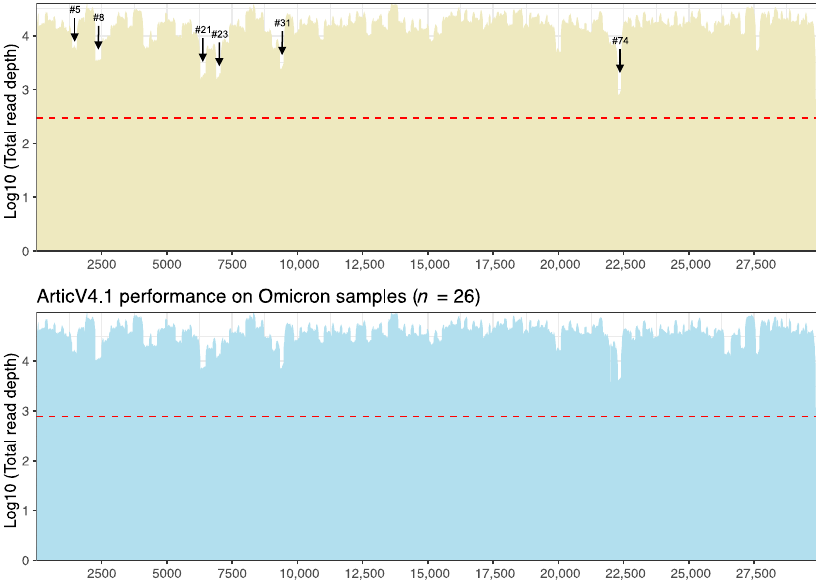
Figure 3. Summarized total breadth of coverage for Delta and Omicron samples sequenced using the ArticV4.1 primer scheme. The X -axis represents genome positions. The Y -axis represents log10 transformed total read depth for each variant. The red dashed lines indicate the minimum total read depth of n samples for reliable mutation calling, calculated as [the minimum depth required (30X) × number of samples of Delta or Omicron]. Low coverage amplicon regions are marked out in black arrows.